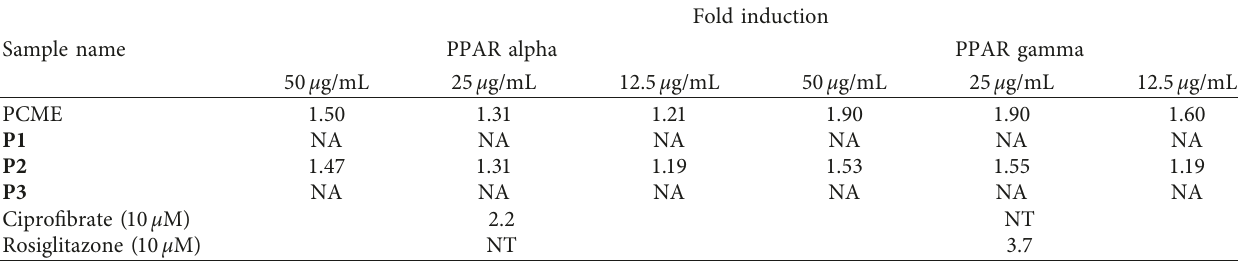
Table 1: PPAR agonistic activity of PCME and P1 , P2 , and P3